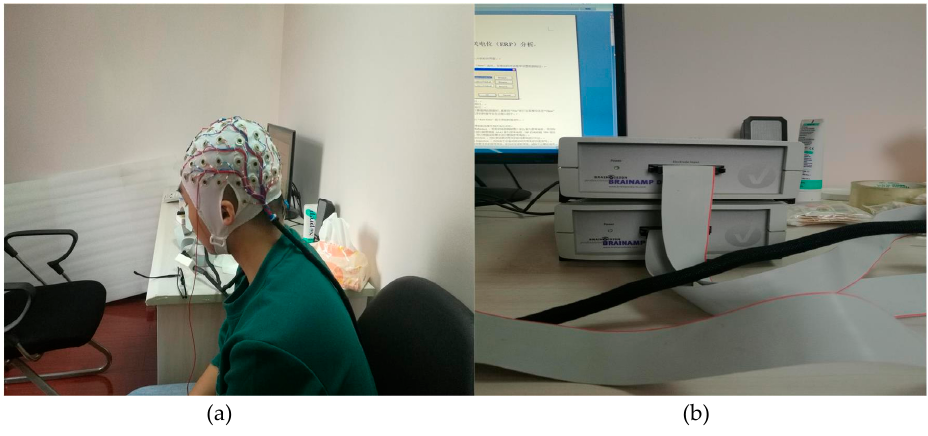
Figure 6. BP equipment. ( a ) BP collection cap; ( b ) BP signal processing box.